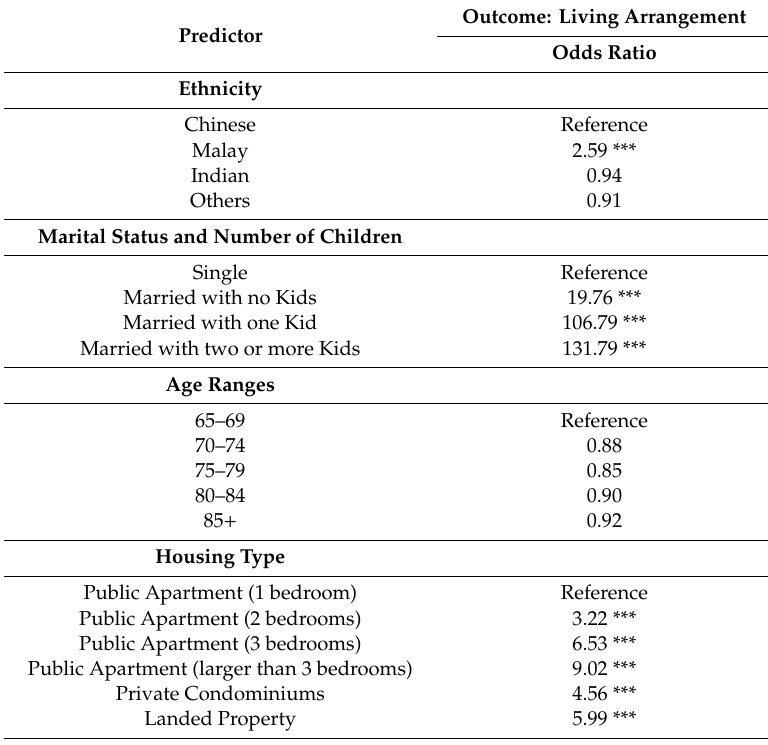
Table 3. Factors associated with living